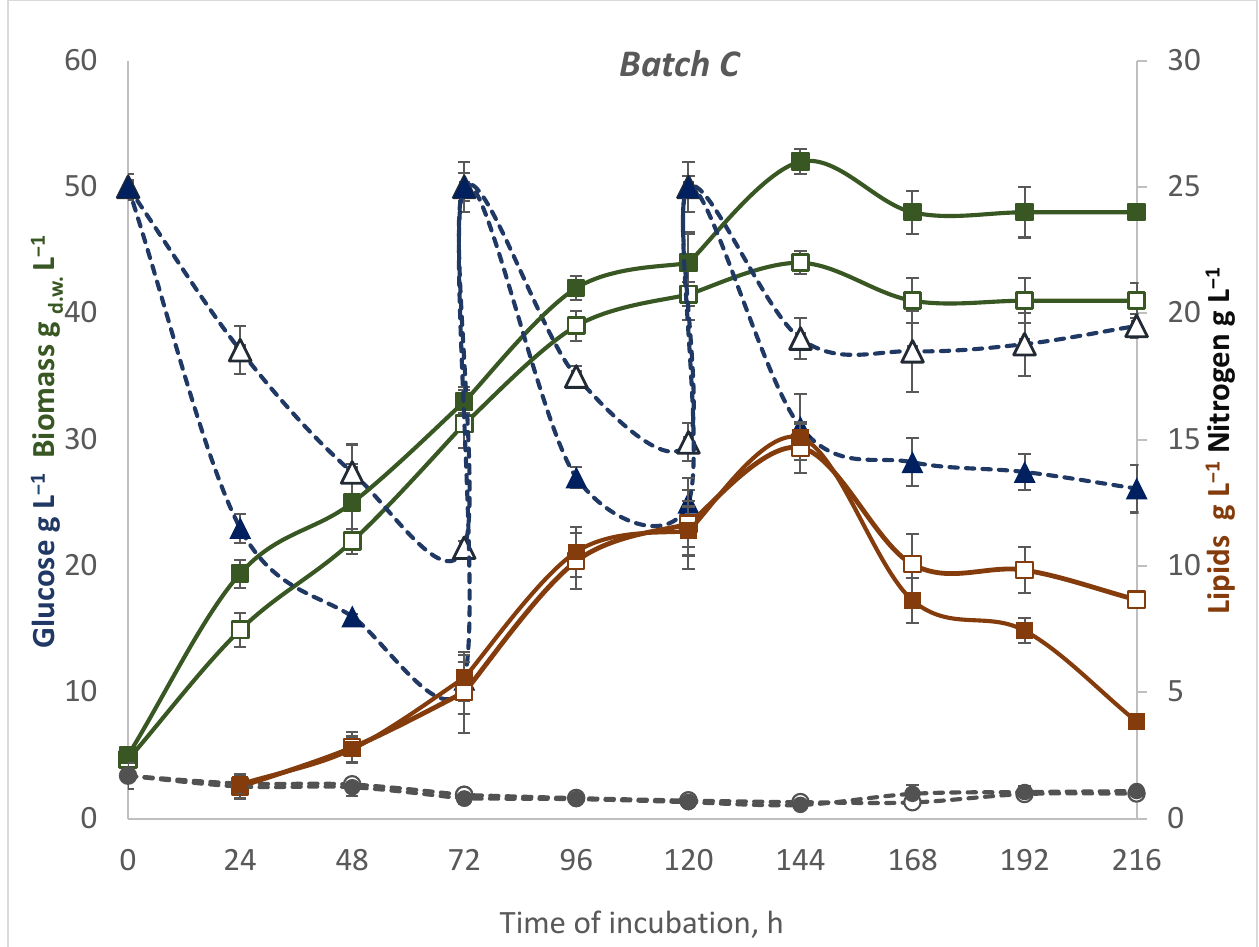
Figure 3. The timecourse of a fed-batch (C) culture of R. glutinis var . rubescens in DPW at two temperatures: 28 °C (filled tags) and 20 °C (empty tags). Kinetics of substrates: glucose — blue dotted line, nitrogen — grey dotted line, biomass (where d.w. — dry weight) — green line, lipids — brown line. Values represent the average of duplicate experiments.